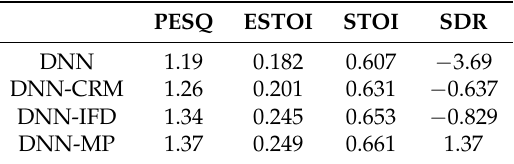
Figure 9. Performance comparison in terms of spectrogram for buccaneer1 noise at − 5 dB SNR level. Table 2. Generalization ability on unseen